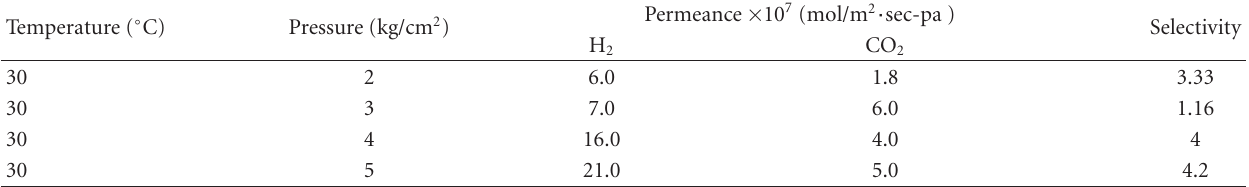
Table 2: Room temperature single-gas permeation for H 2 and CO 2 through SAPO 34 membrane on the support treated with PVP at 30 ◦ C. Temperature ( ◦